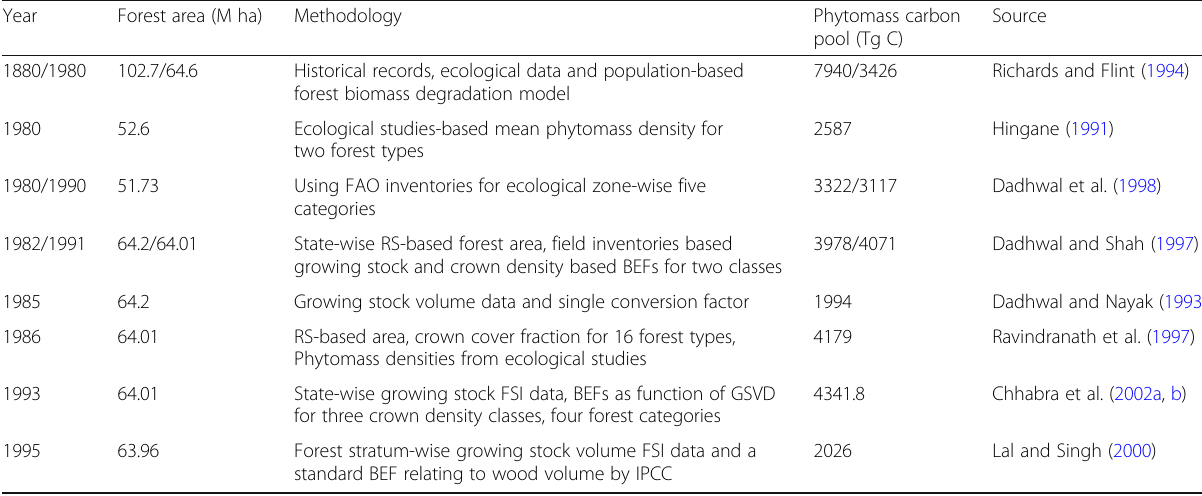
Table 2 Carbon pool estimates of Indian forest Year Forest area (M ha)